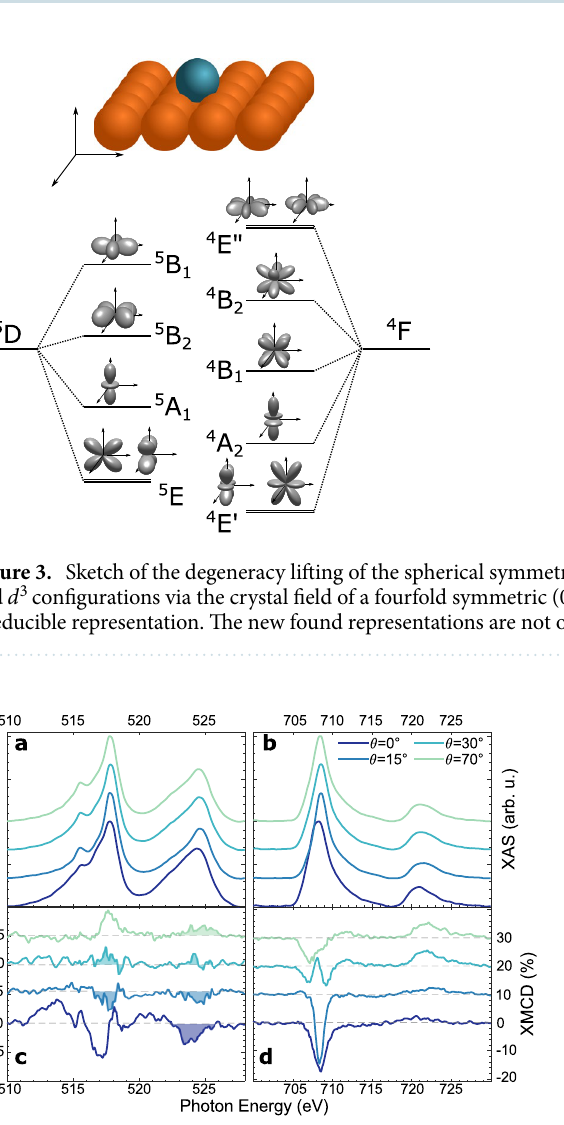
◦ ◦ ◦ ◦ , θ =15 , θ =30 and θ =70 for the V L 2,3 -edges